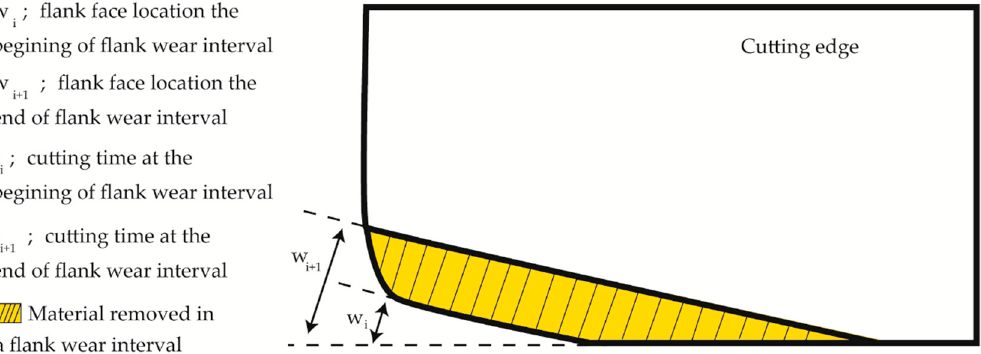
Figure 8. Schematic of wear rate calculation in a flank wear interval.